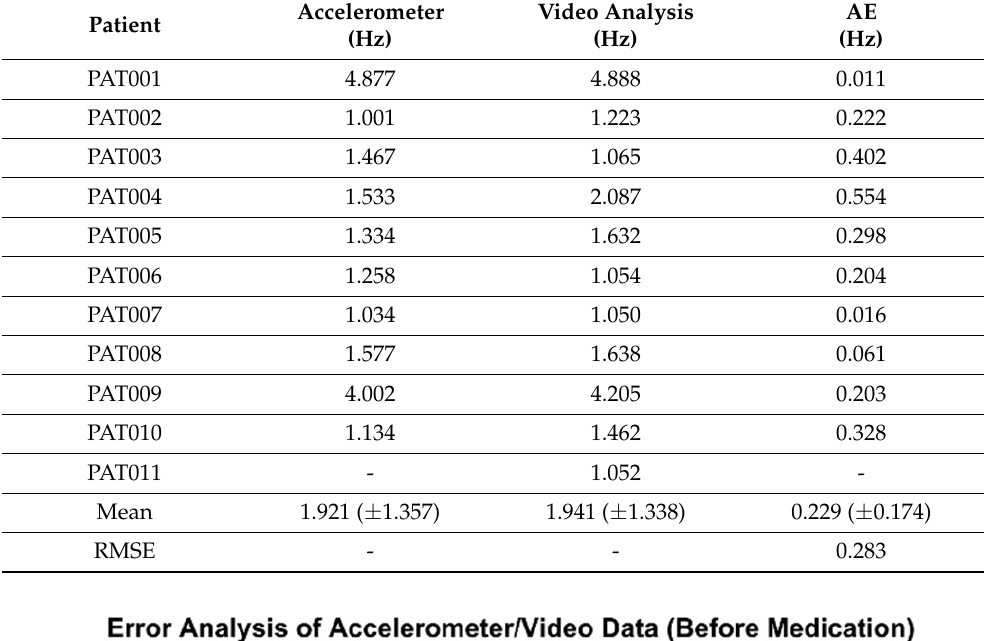
Table 3. Dominant frequencies from the accelerometer and the video data.